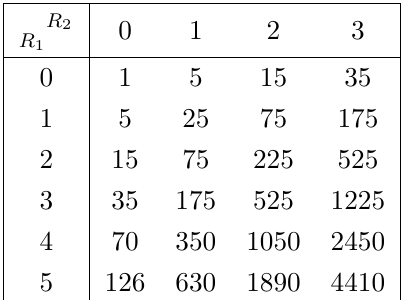
Table 1 . Number of independent tensor structures q µ 1 q 2 indices up to maximal ranks R 1 , 2 in q 1 , 2 , i.e. for r ≤ R 1 and s ≤ R 2